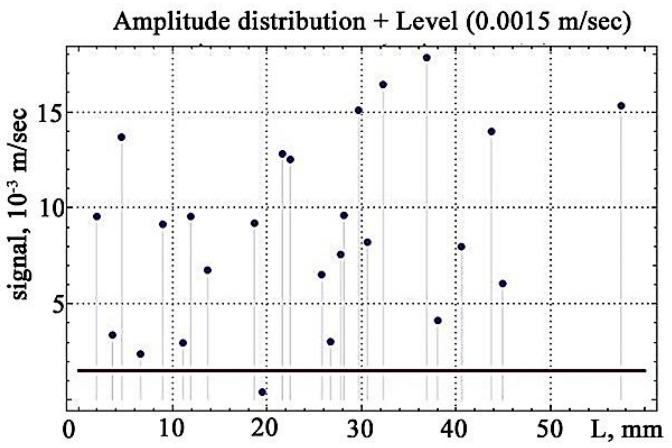
Figure 14. The distribution of the amplitudes of the vibration signals while increasing the applied load